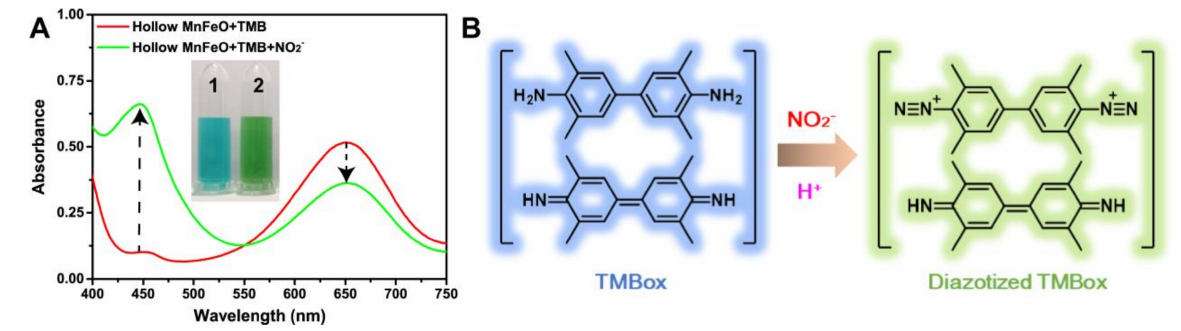
Figure 3. ( A ) records the effect of nitrite on the hollow MnFeO+TMB system, and the inset is the corresponding photo- graph (1—Hollow MnFeO+TMB; 2—Hollow MnFeO+TMB+NO 2 − ). ( B ) illustrates the mechanism for the phenomenon observed in ( A